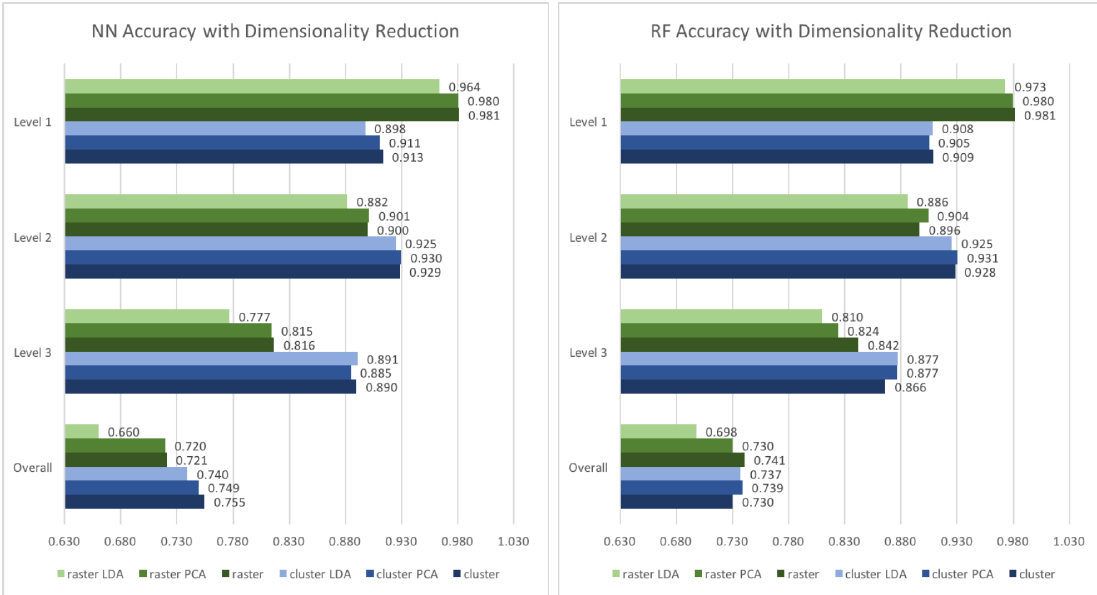
Figure 5. The influence of dimensionality reduction across the different spatial resolutions and machine learning models. Overall, a feature dimensionality reduction does not yield any significant benefits.